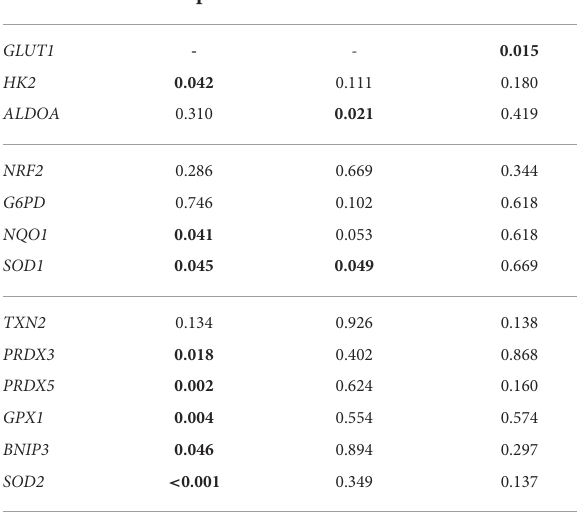
TABLE 3 Statistical data ( p -values) for comparison of mRNA expression between time points I1, I2, R1, R2, and C2 and no flow vs. low flow model using a two-way RM ANOVA (with post-hoc Holm-Sidak